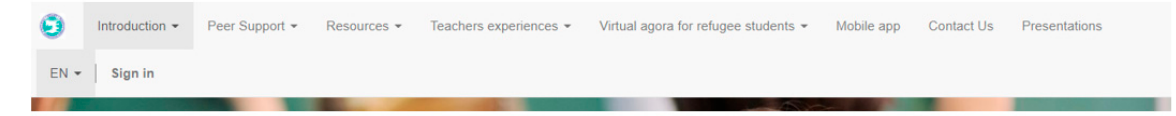
Figure 6. Interface of REFUGEEClassAssistance4Teachers portal [21].